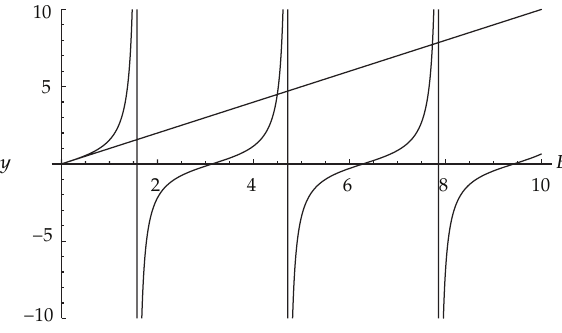
Figure 6: Graph of y (cid:5) tan B and y (cid:5) B against B for B in the range (cid:6) 0,10 (cid:7)